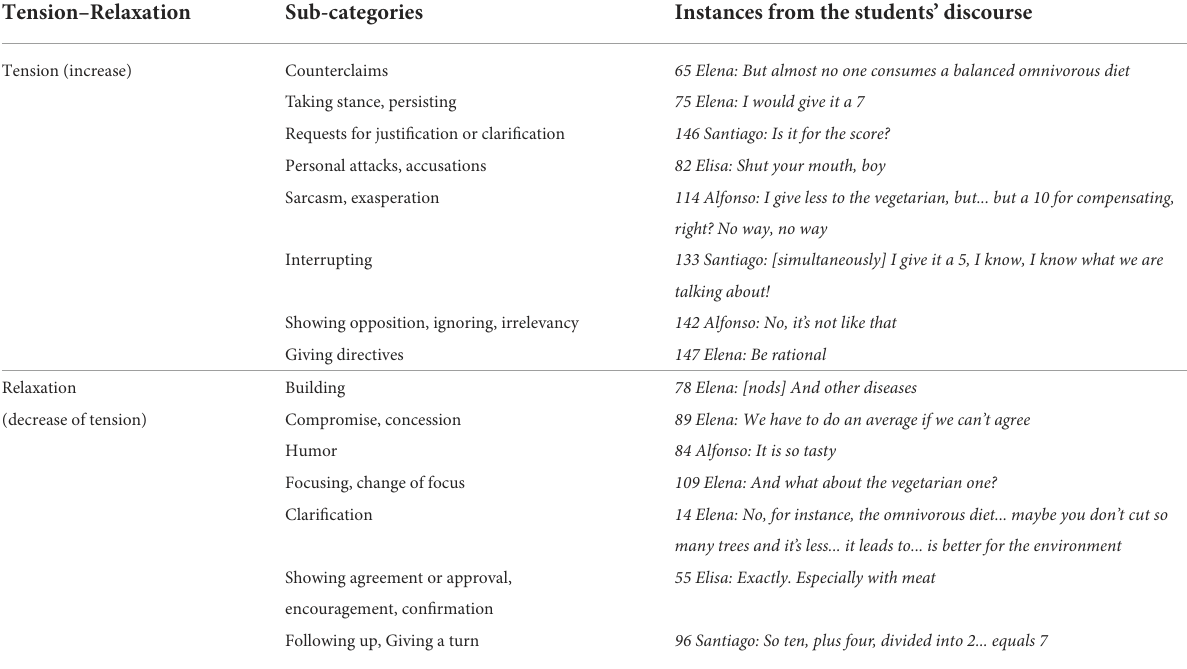
TABLE 2 Coding categories for the analysis of the socio-cognitive tension/relaxation patterns (adapted from Andriessen et al., 2011).